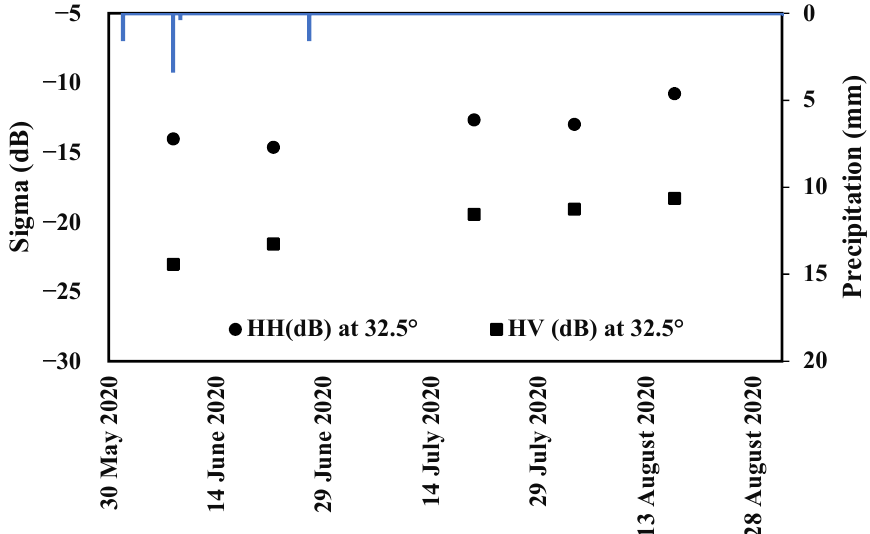
Figure 4. L ‐ band ALOS ‐ 2 backscattering coefficients (sigma) in dual ‐ polarization HH and HV at an Figure 4. L-band ALOS-2 backscattering coefficients (sigma) in dual-polarization HH and HV at incidence angle of 32.5° and precipitation quantity temporal evolutions during June, July, and an incidence angle of 32.5 ◦ and precipitation quantity temporal evolutions during June, July,